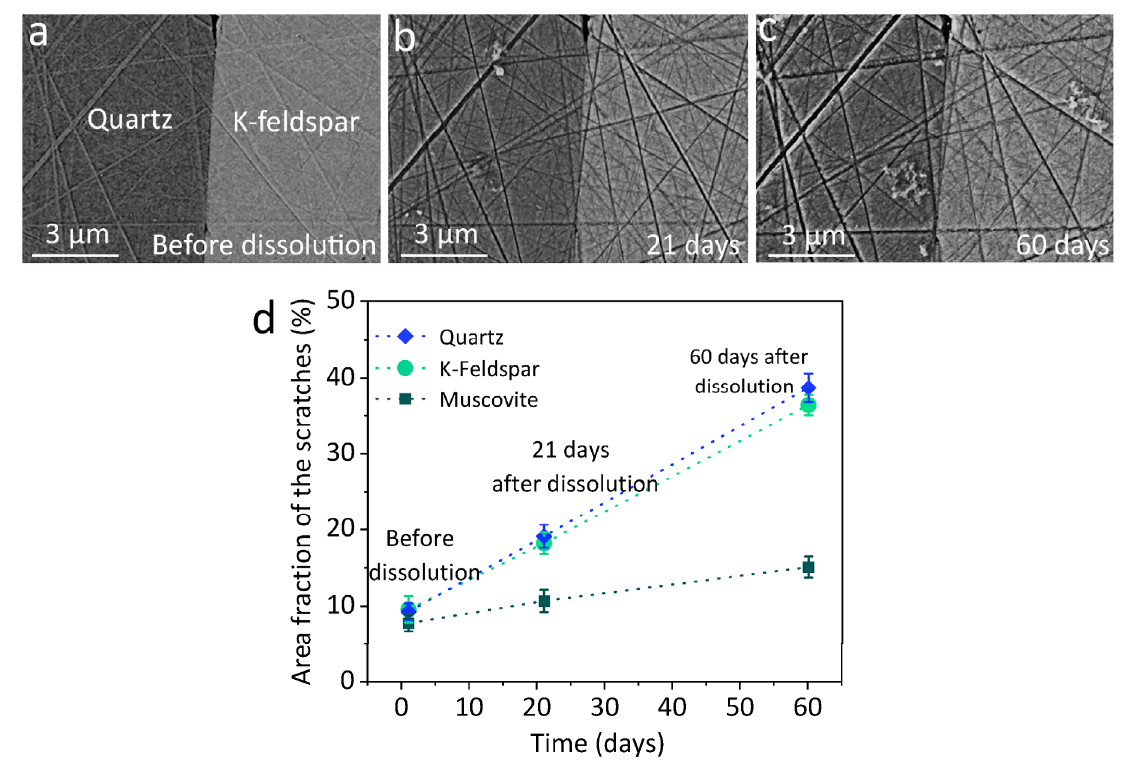
Figure 1. Aligned SEM secondary electron images of (a) quartz and K–feldspar areas of P aggregate before dissolution, (b) after 21 days and (c) 60 days of dissolution in 0.4 M KOH solution at 38 °C, and (d) scratch area fraction (%) for quartz, K ‐ feldspar and muscovite areas of P aggregate before dissolution, after 21 and 60 days of immersion in 0.4 M KOH solution at 38 °C. Adapted from